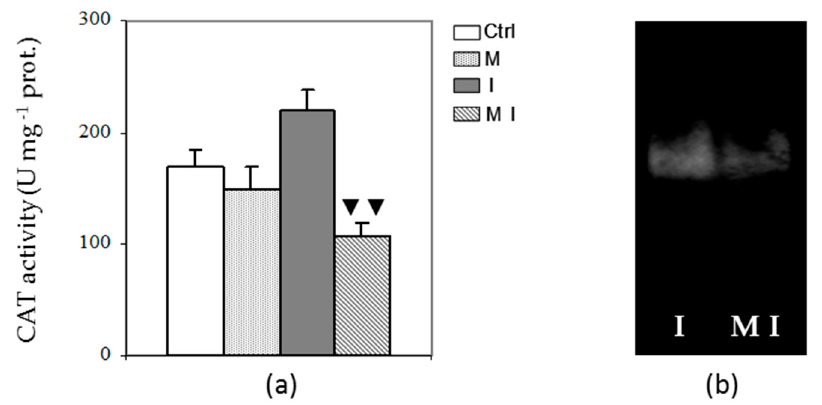
Figure 5. Spectrophotometric activity ( a ) and electrophoretic profile ( b ) in the cytosolic fraction of catalase (CAT) in artichoke control plants (Ctrl), in mycorrhizal plants (M), in plants inoculated with Verticillium dahliae (I), and in mycorrhizal plants inoculated with V. dahliae (MI); 1 U = 1 nmol H 2 O 2 dismutated min − 1 ; prot. = proteins. The results are given as the mean values of at least five experi- ments ± SD; ▼▼ indicates values significantly different from the artichoke inoculated with V. dahliae (I) by the Student’s t test with p < 0.01.